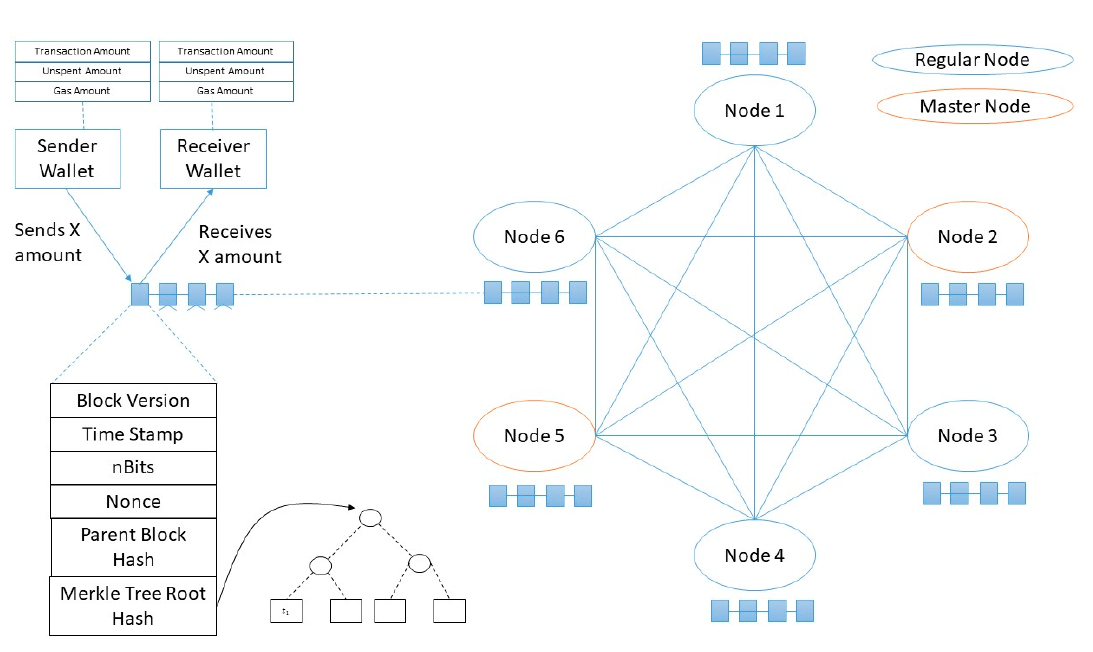
Figure 1. Blockchain and Its Network.